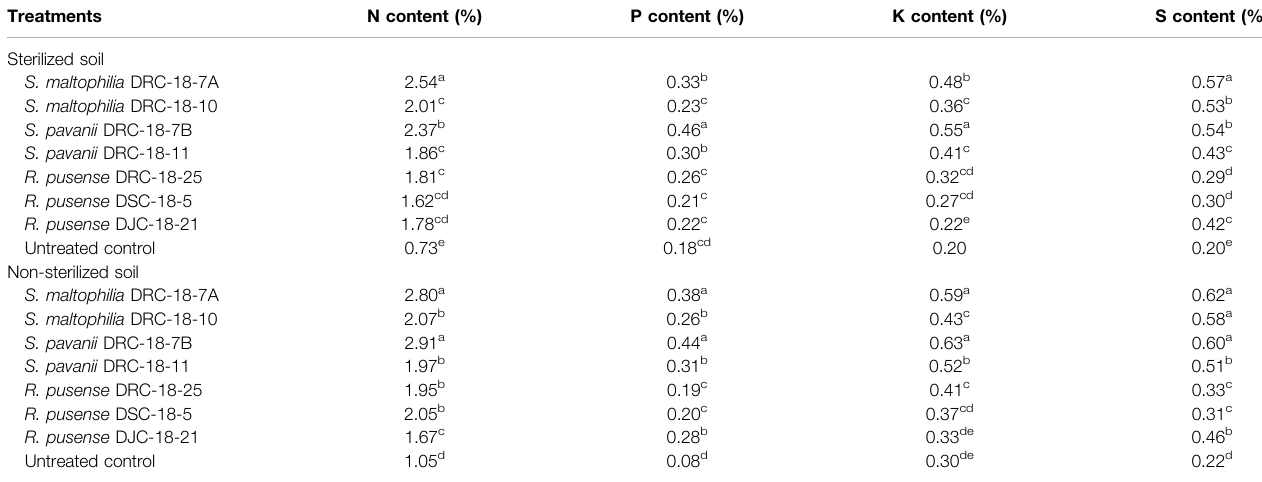
TABLE 6 | Effect of seed inoculation of SOB on nitrogen, phosphorous, potassium, and sulfur content in the leaves of pigeonpea after 60 days of sowing. Treatments N content